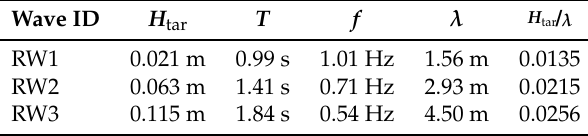
Table 2. Characteristics of the regular